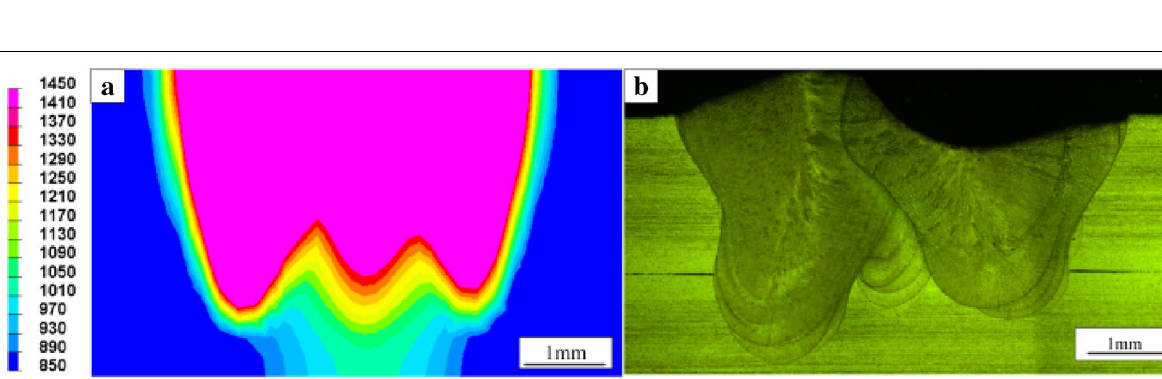
Figure 15 Welding method is 4-sections of joint morphology: a Numerical simulation of molten pool morphology; b Actual welded joint